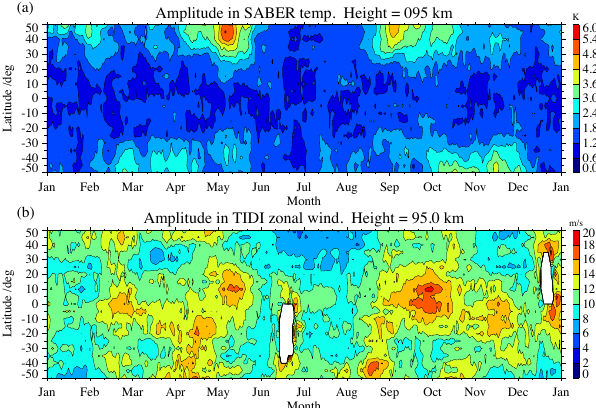
Amplitude in SABER temp. Height = 095 km